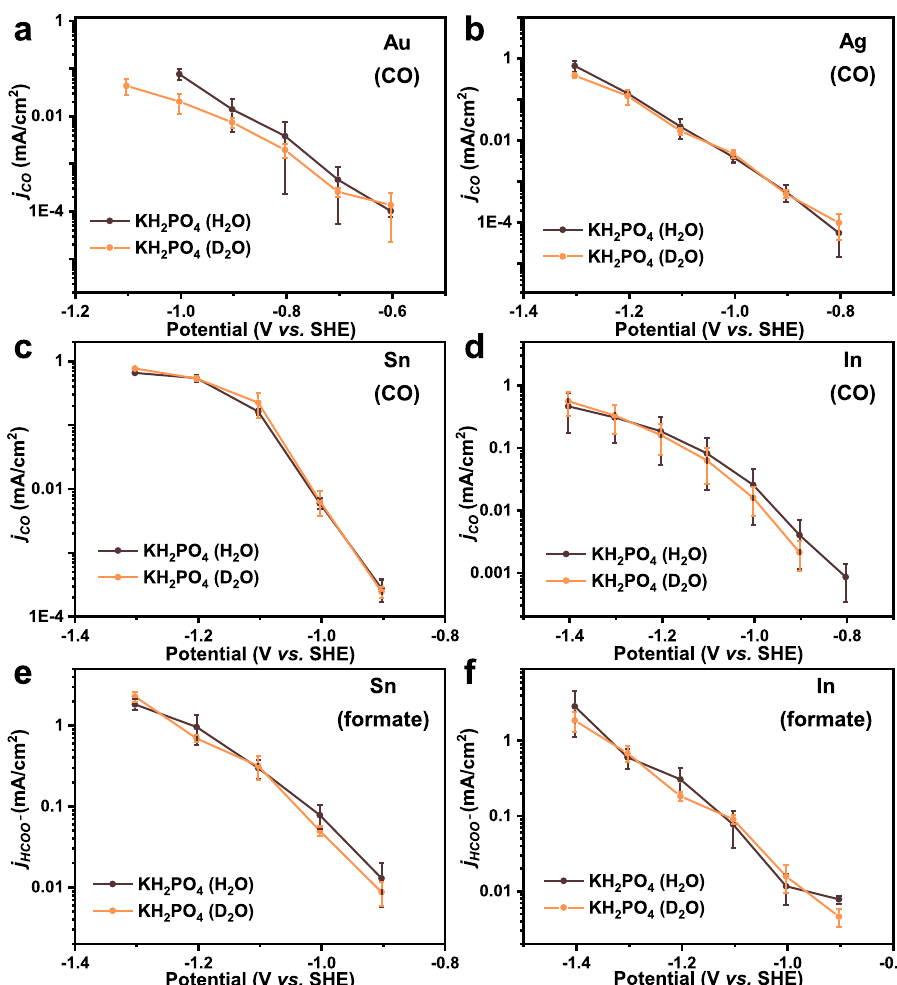
Fig. 3 Kinetic isotope effect for CO 2 ER toward CO and formate. The j CO for Au ( a ), Ag ( b ), Sn ( c ), and In ( d ) in 0.1 M KH 2 PO 4 electrolytes with D 2 O and H 2 O. The j HCOO − for Sn ( e ) and In ( f ) in 0.1 M KH 2 PO 4 electrolytes with D 2 O and H 2 O. Error bars are means ± standard deviation ( n = 3